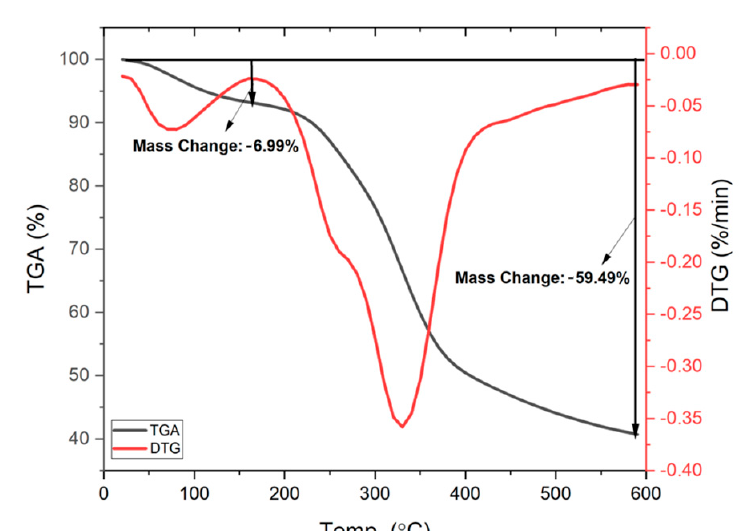
Figure 2. TGA curve of NZ.